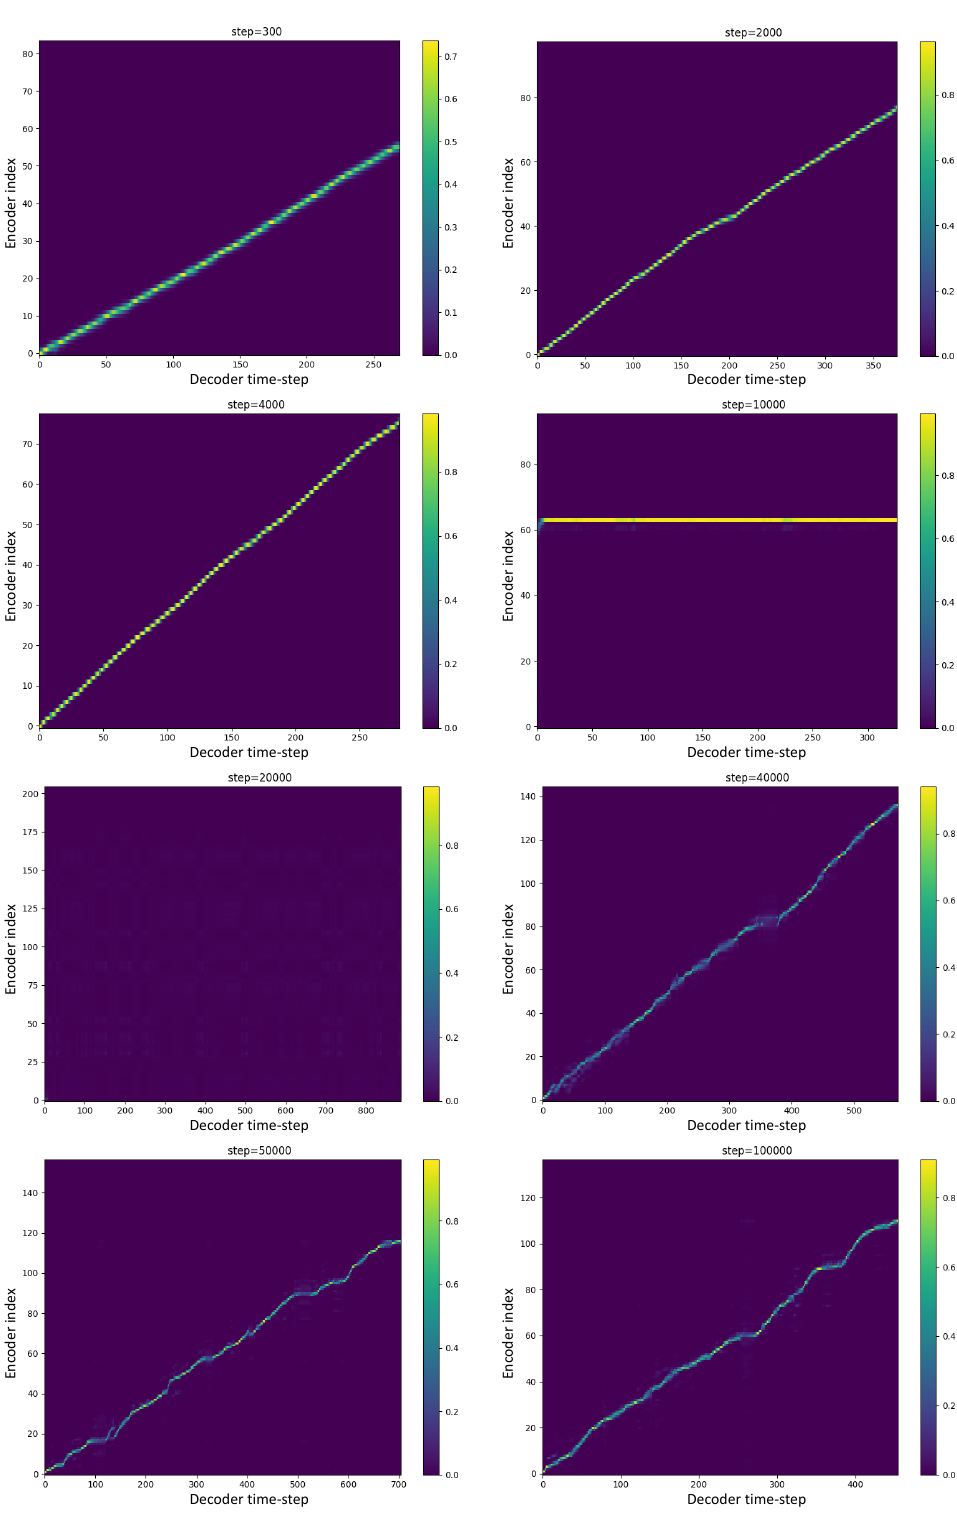
Figure A3. Attention plot during training Tacotron2-GST-GRA with guided